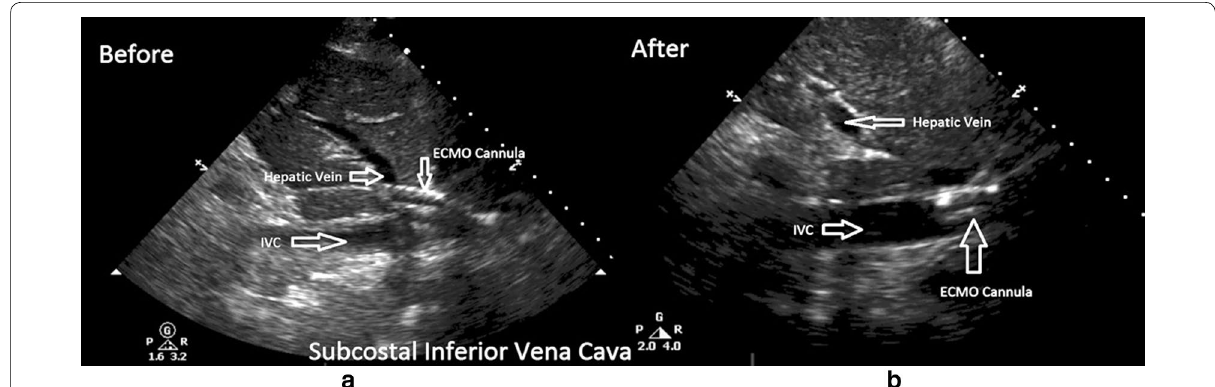
Fig. 3 Still Images taken from the subcostal inferior vena cava view on the TTE exam. a Image taken during low flows on the ECMO circuit. The ECMO cannula is visualized as a hyperechoic structure located in the hepatic vein. b Resolution of low flows on ECMO circuit after catheter reposi- tioning. The ECMO cannula is now located in the lumen of the inferior vena cava. IVC inferior vena